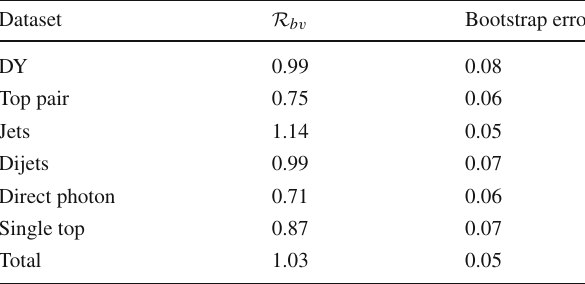
Table 25 The bias-to-variance ratio R b v , Eq. (6.15), divided by groups of processes and evaluated for the testing datasets that were not used as input to the NNPDF4.0 closure test fits. The last column indicates the uncertainty associated to R b v , determined as its standard deviation over a bootstrap sample of both fits and replicas